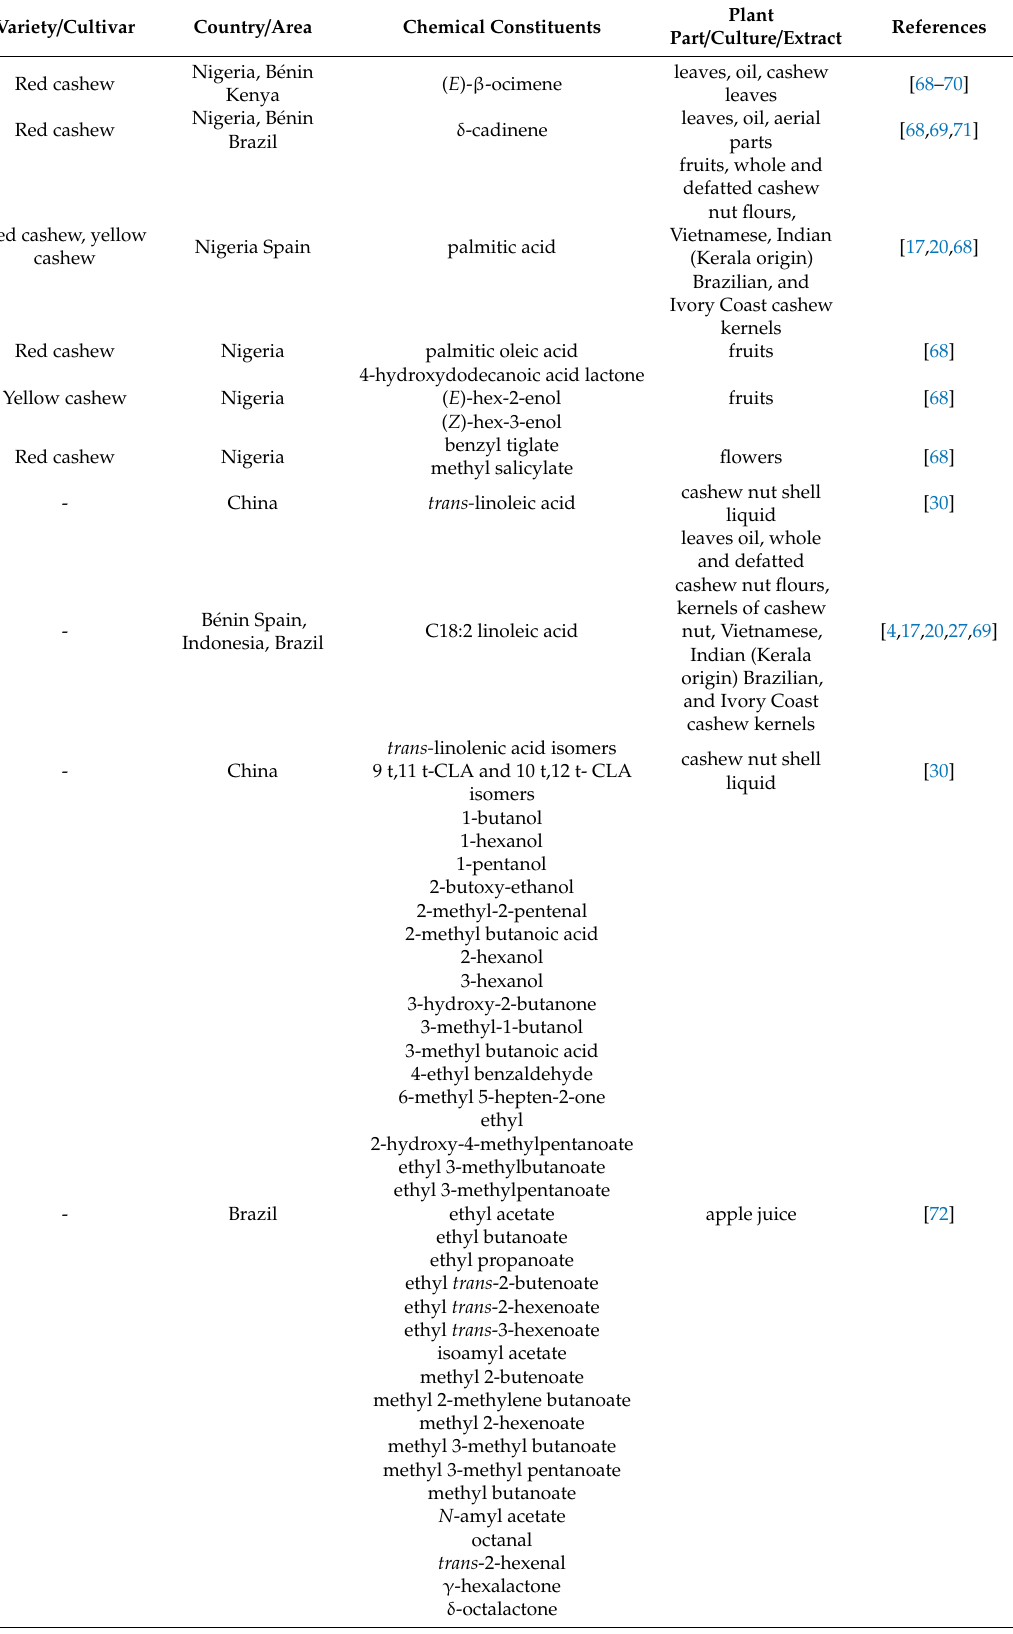
Table 7. Oil and volatile composition of Anacardium